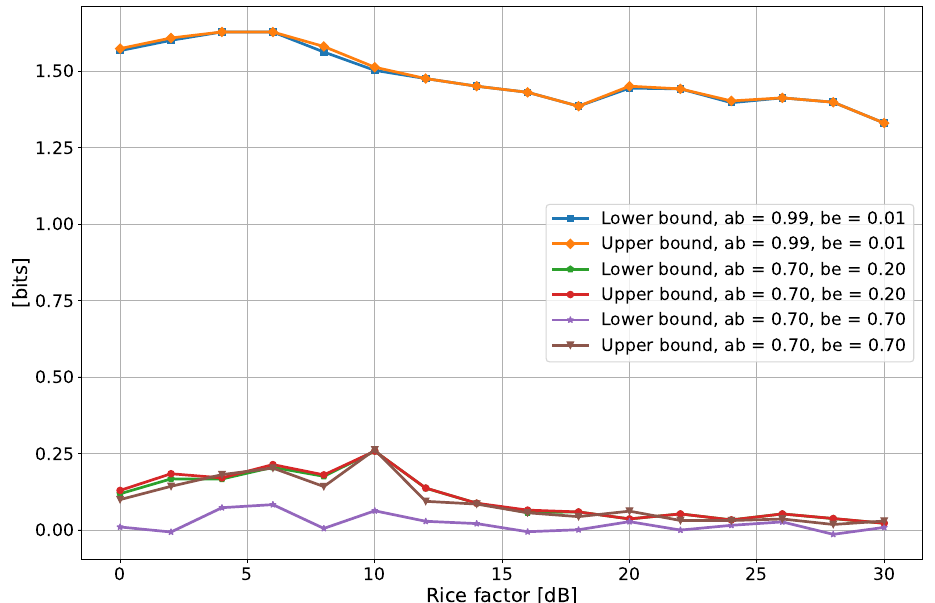
Figure 6. Secrecy key rate as a function of the Rice factor K, for different values of the correlation and with 1 filter. In the legend, “ab” and “be” stand for Alice–Bob correlation and Bob–Eve correlation.